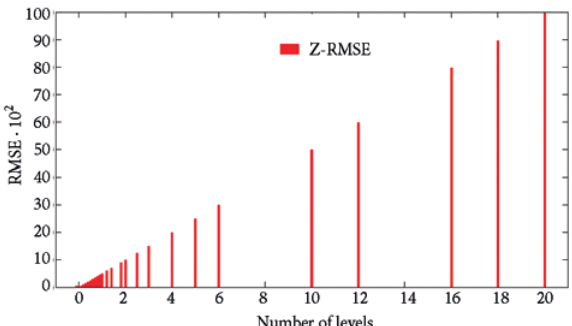
Fig. 12. RMSE (Height) changing by increasing distance of initial value of point’s height from real value of point’s height